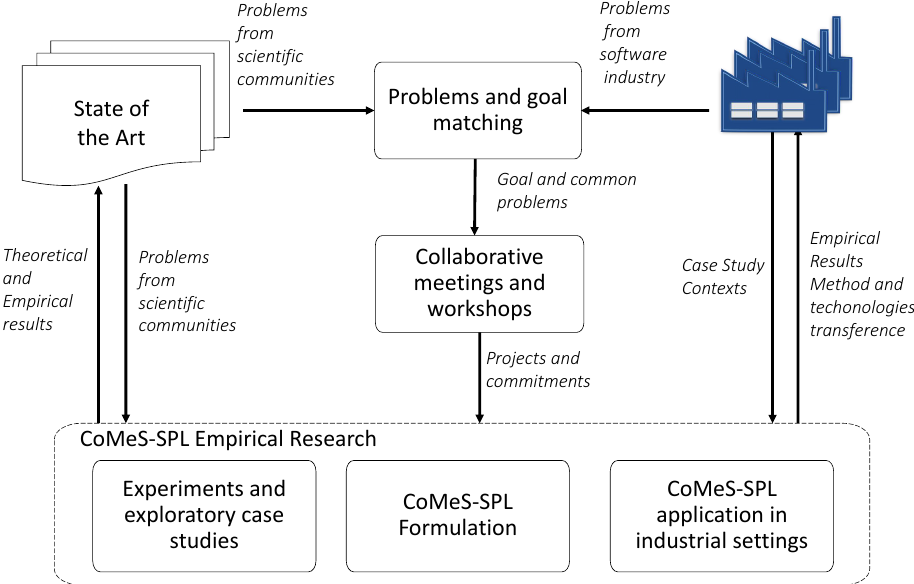
Figure 5. Empirical research